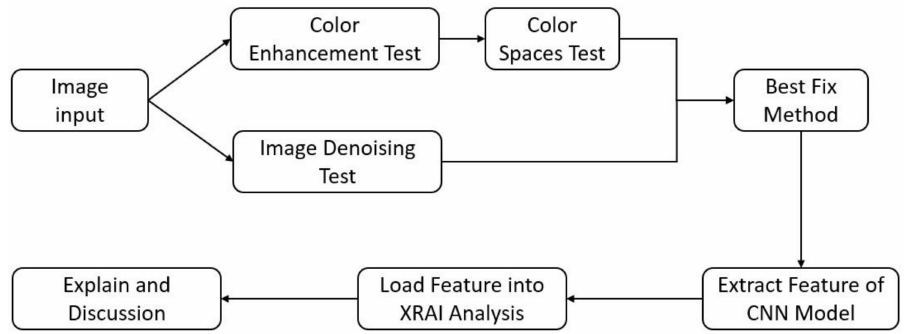
Figure 3. Flowchart of the study design.